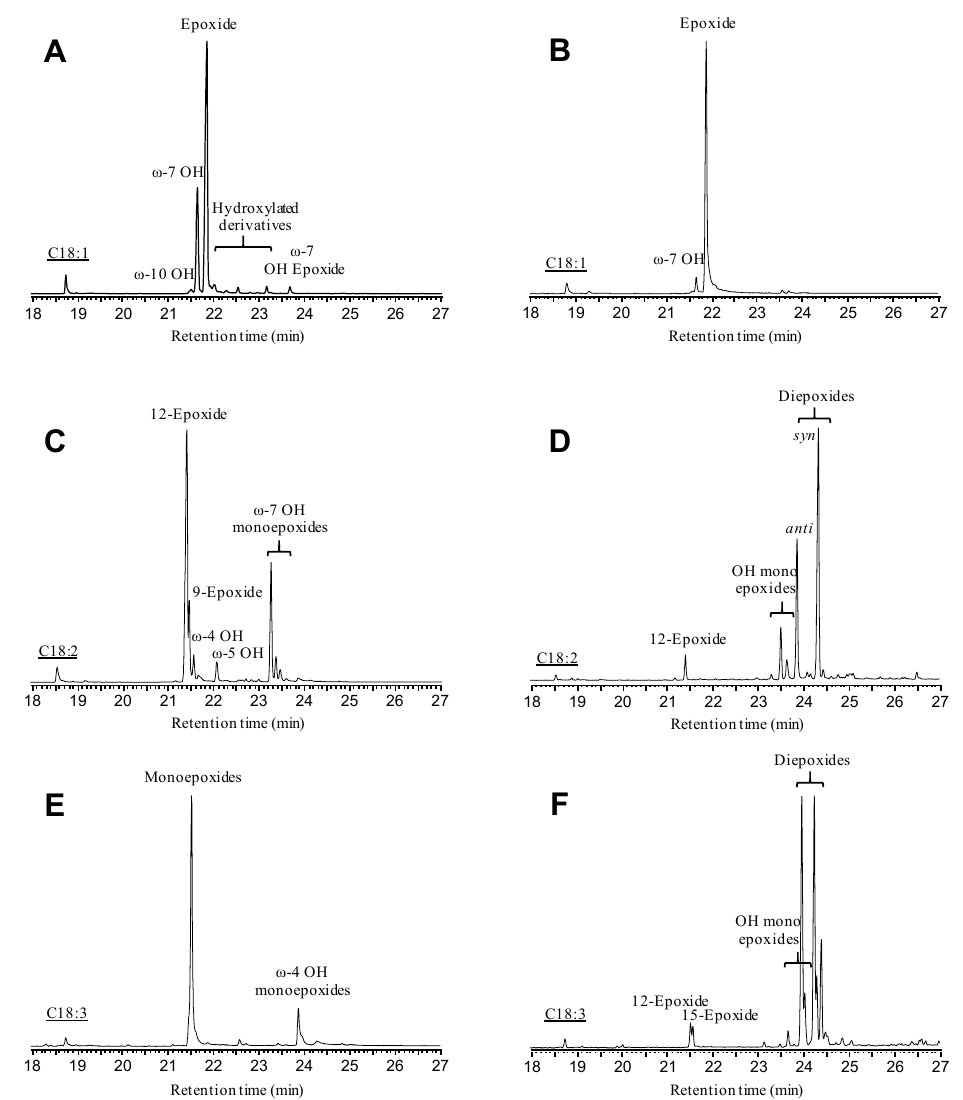
Figure 3. GC-MS profiles of selected epoxidation reactions of: (i) oleic acid (C18:1) treated with the 6Ala variant ( B ) compared with native r Cvi UPO ( A ), (ii) linoleic acid treated with the F88A/T158A variant ( D ) compared with the native r Cvi UPO ( C ), and (iii) α –linolenic acid treated with the F88A/T158A variant ( F ) compared with the native r Cvi UPO ( E ) (see Figures S5–S7 for the whole set of reactions). Mixtures containing 0.1 mM substrate, 0.25–0.40 µ M enzyme, and 1.25 mM H 2 O 2 were incubated for 30 min, extracted, and derivatized before GC-MS